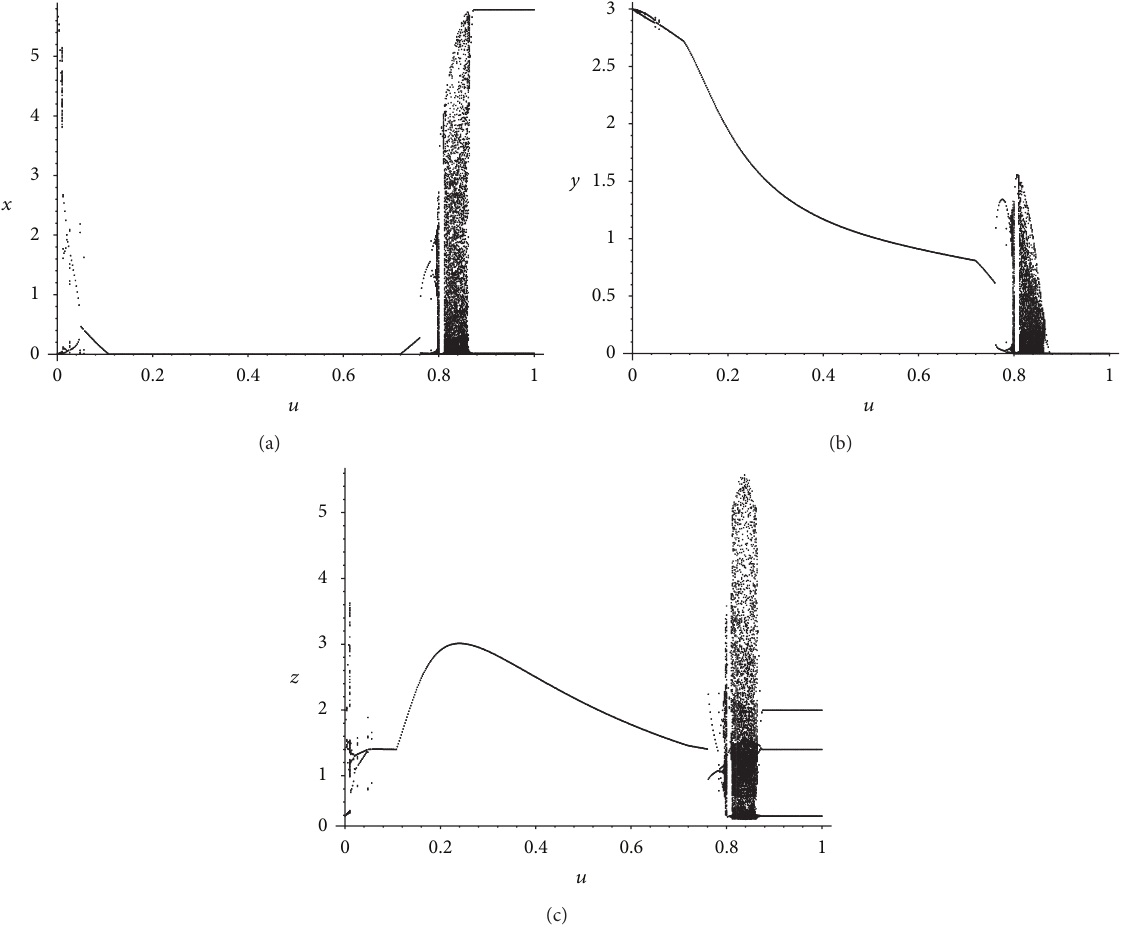
Figure 4: Bifurcation diagram of System (2) with initial conditions 𝑝 = 1.45 , 𝑥(0) = 0.3 , 𝑦(0) = 0.5 , 𝑧(0) = 0.3 , and 0 ≤ 𝑢 ≤ 1 .